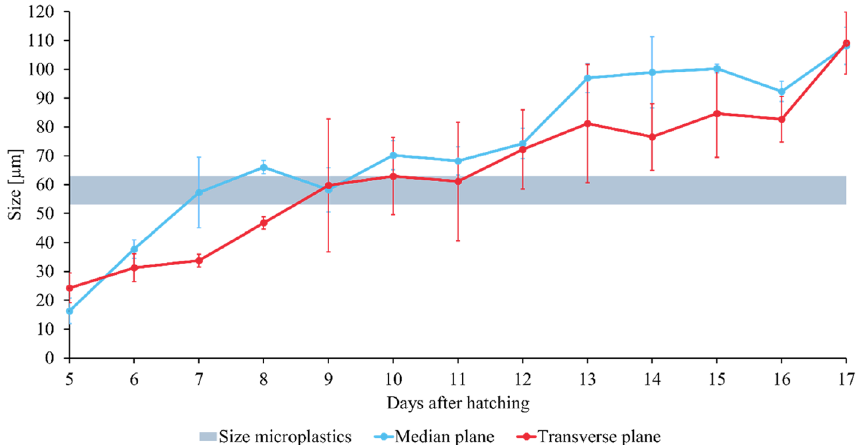
Figure 7. Larval mouth opening (median and transverse plane) as a function of their age. The size of the microplastics (53–63 µm) is depicted by the grey bar. The results provided are the means ( n = 3), while the error bars display the standard